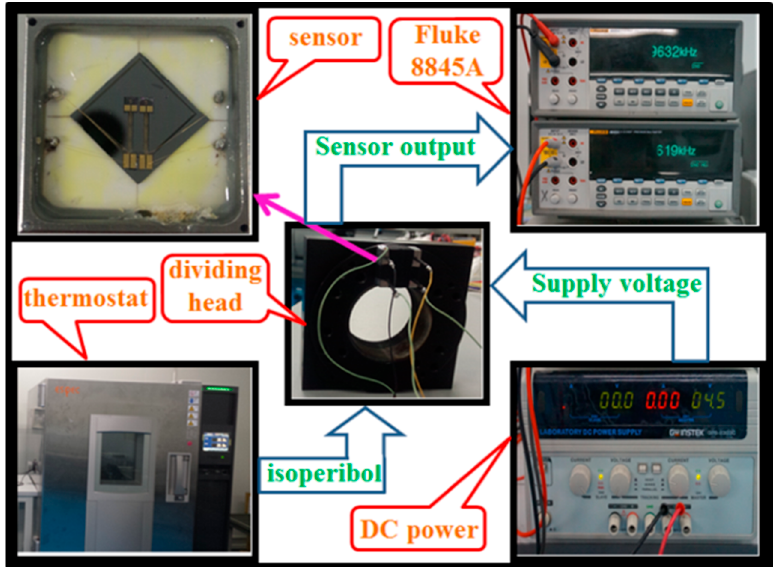
Figure 23. Experimental system of static testing by rotating sensors on a dividing head.